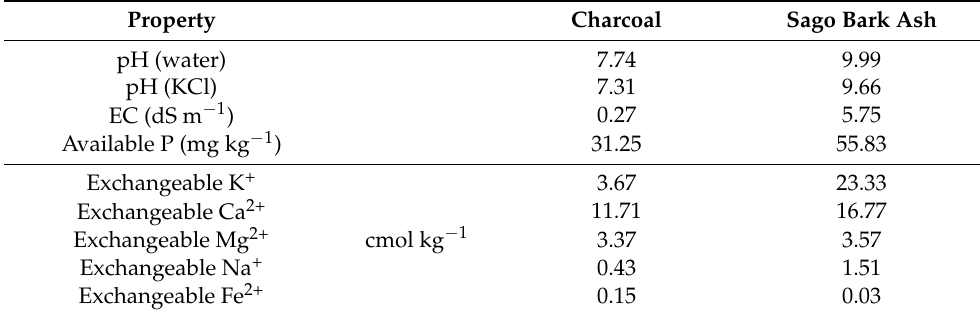
Table 3. Selected chemical properties of charcoal and sago bark